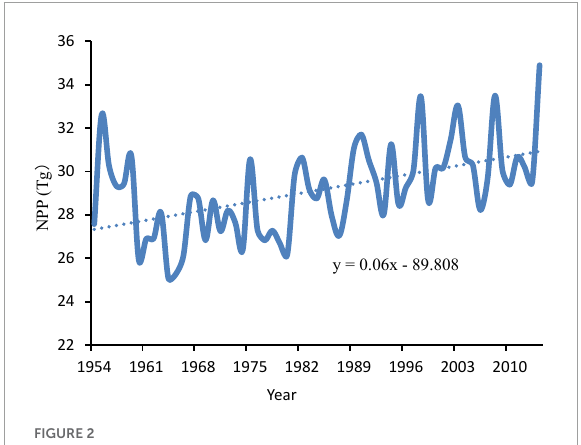
FIGURE2 Temporal changes of net primary productivity since 1954 in the marsh area of the Sanjiang Plain.